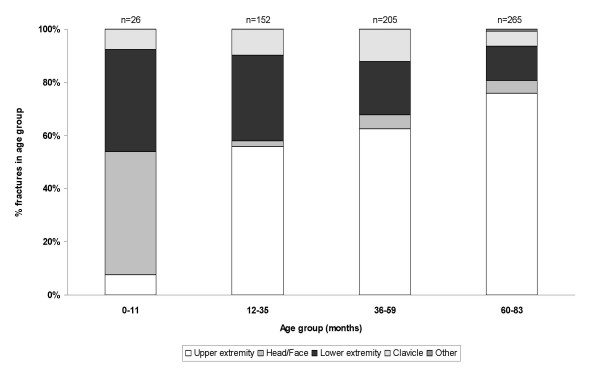
Anatomic location of fracture by age group